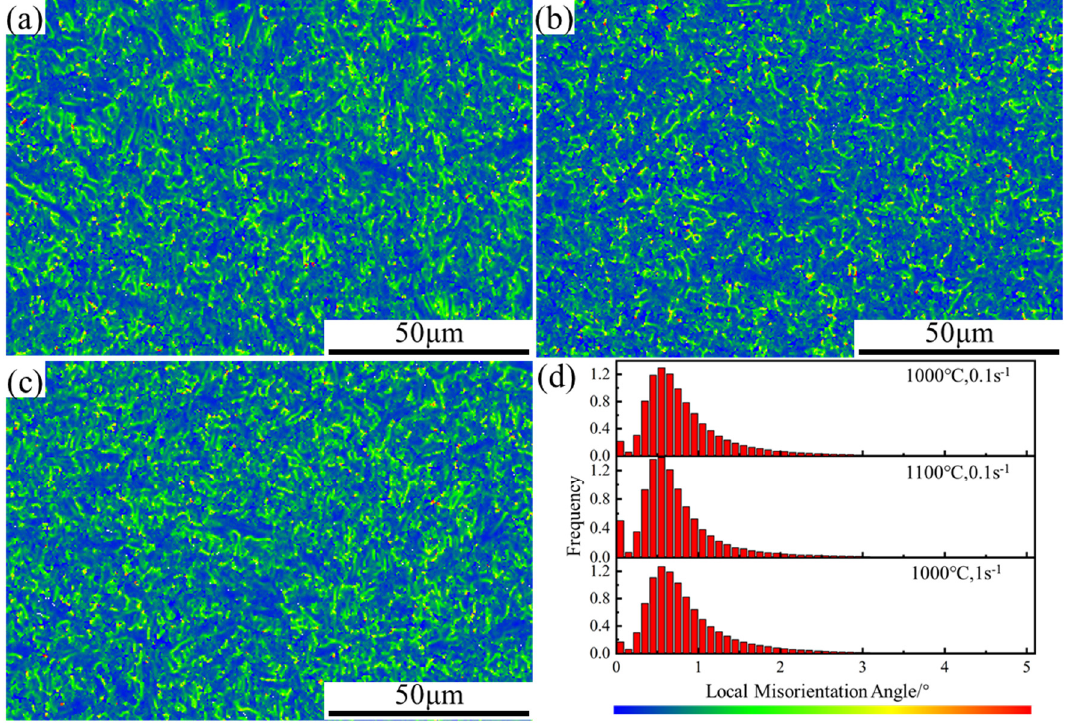
Figure 6. Distribution maps of local misorientation at different compression conditions. ( a ) T = 1000 °C, 𝜀 (cid:4662) = 0.1 s − 1 ; ( b ) T = 1100 °C, 𝜀 (cid:4662) = 0.1 s − 1 ; ( c ) T = 1000 °C, 𝜀 (cid:4662) = 1 s − 1 .